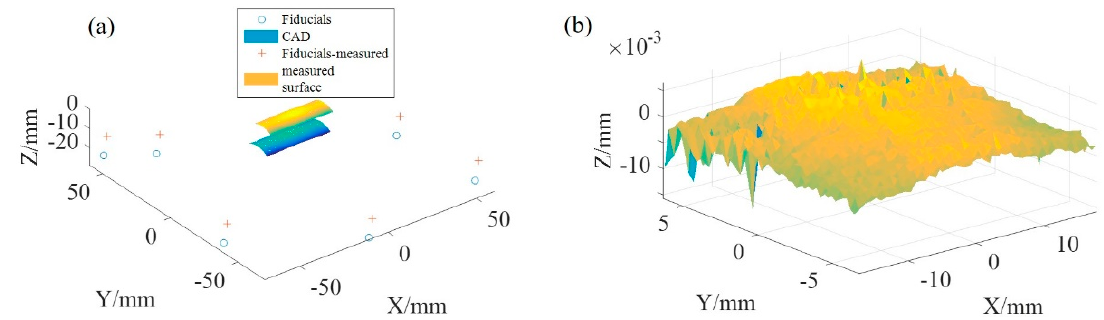
Figure 8. ( a ) FA-CAD and fiducial-aided measured surface (FA-MS); ( b ) 3D form error evaluation.